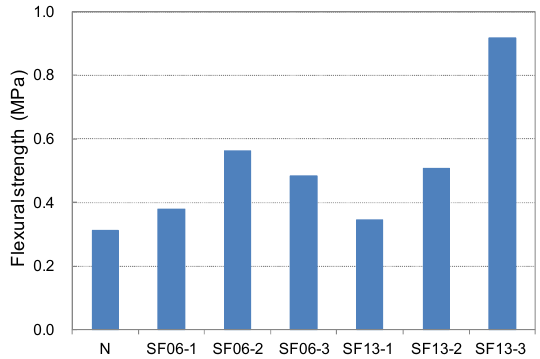
Figure 14. Tensile strength of steel fiber mortar.